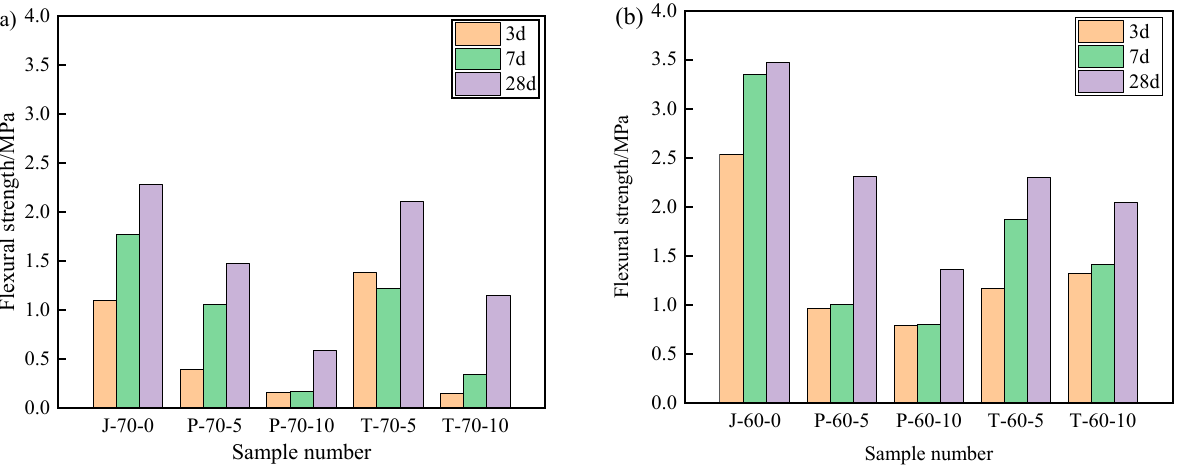
Figure 10. Flexural strength of recycled aggregate pavement bricks containing PEG-400/SiO 2 and Tet/SiO 2 composite shaped PCM: ( a ) 70% brick slag; ( b ) 60% brick slag.